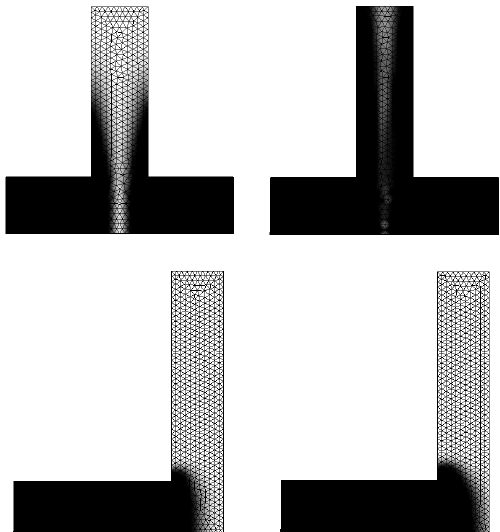
Figure 2. Filling problems of front joining for specific cavities in shapes K and L.